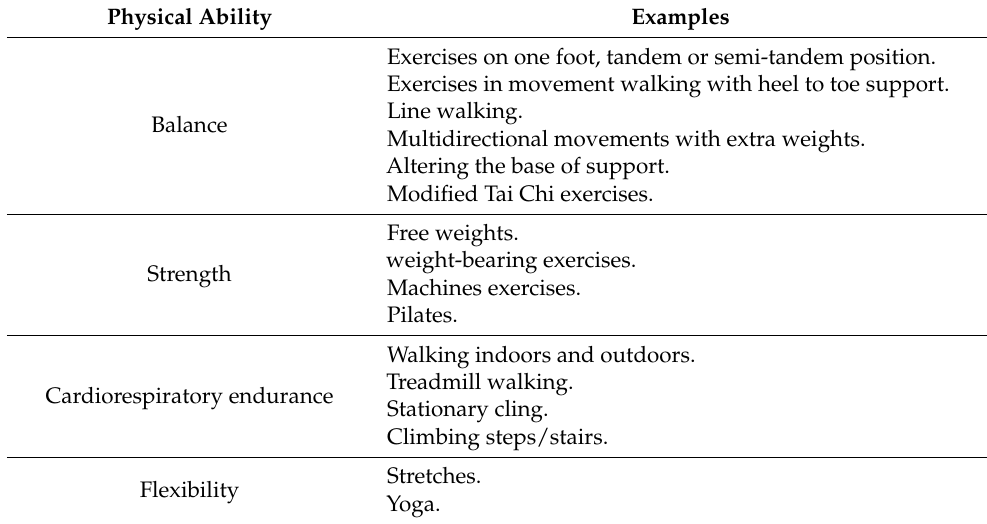
Table 1. Examples of the activities and exercises performed according to the physical abilities in the multi-component training programme. Physical Ability Examples Exercises on one foot, tandem or semi-tandem position. Exercises in movement walking with heel to toe support. Line walking. Balance Multidirectional movements with extra weights. Altering the base of support. Modified Tai Chi exercises. Free weights. weight-bearing exercises. Strength Machines exercises. Pilates. Walking indoors and outdoors. Treadmill walking. Cardiorespiratory endurance Stationary cling. Climbing steps/stairs. Stretches. Flexibility